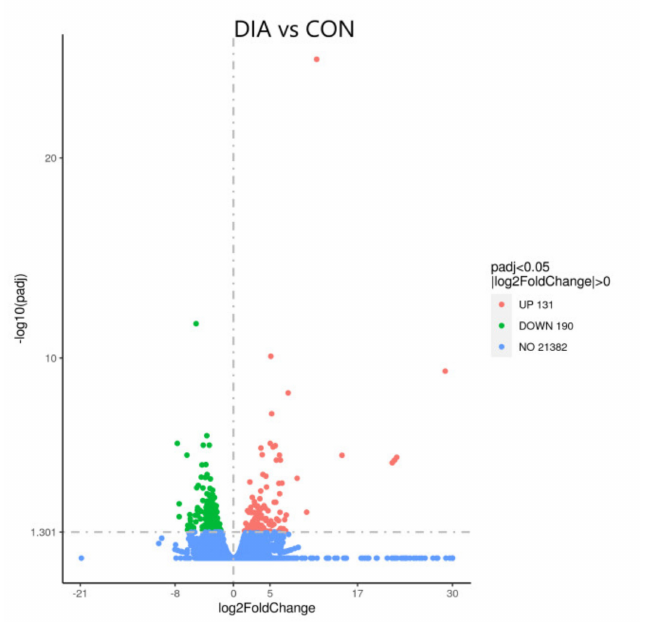
Figure 5. Volcano-map of DEGs in colon tissue of DIA and